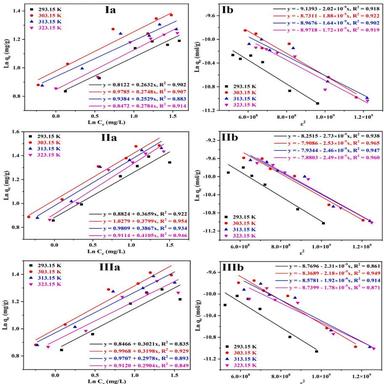
(a) Freundlich and (b) Dubinin-Radushkevich adsorption isotherm of TTC onto (I) Ti-TPA-Si, (II) Ti-TPA-Si-C, and (III) Ti-TPA-Si-CS at different temperatures.